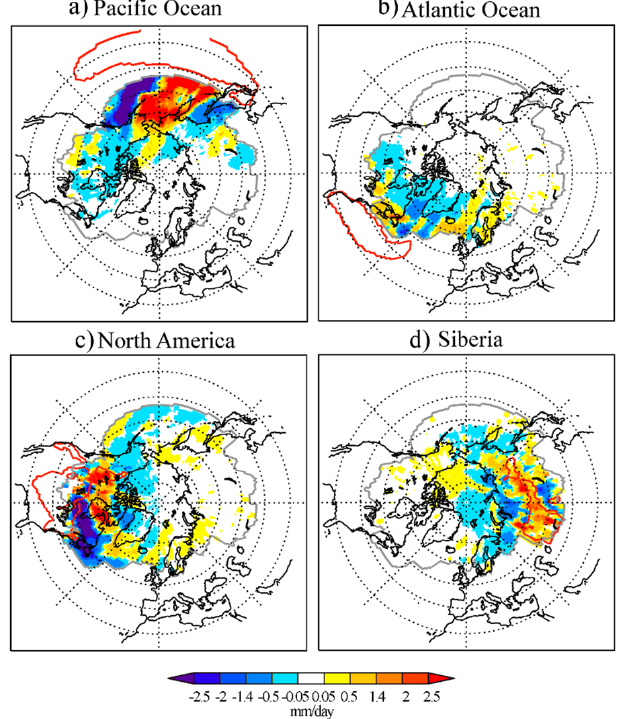
Figure 10. Summer (E–P) < 0 anomalies for 1996 in the forward experiment from ( a ) the Pacific Ocean ( b ) the Atlantic Ocean ( c ) North America and ( d ) Siberia. Reddish colours represent areas over which the moisture supply is greater that year from the selected source (positive anomalies) and bluish colours represent areas where the moisture uptake is lower that year (negative anomalies). Contour red lines represent climatological moisture sources for the Arctic system.